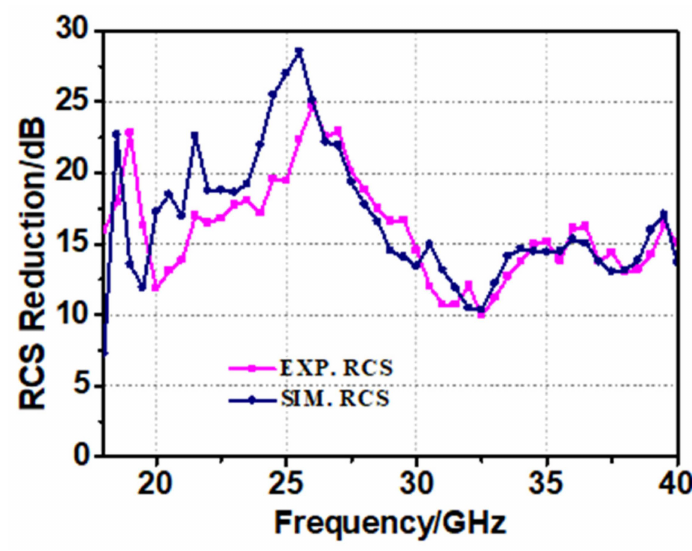
Figure 18. Comparison of RCS reduction measured by simulation and experiment. Table 1. Comparison with the present state-of-the-art for polarization conversion metasurface (PCM). OB